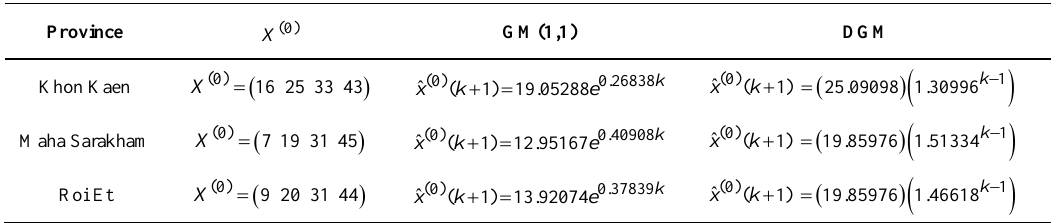
Table 3. Forecasting model of GM(1,1) and